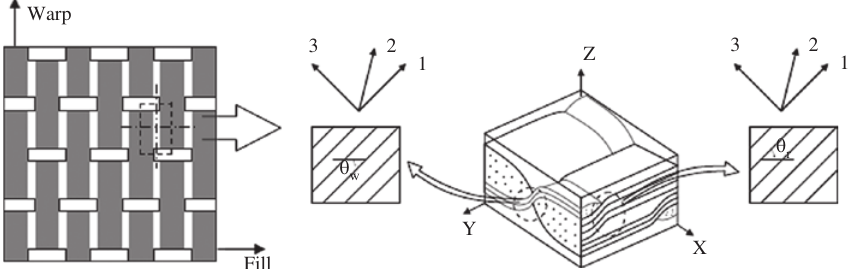
Figure 1: Unit-cell geometry